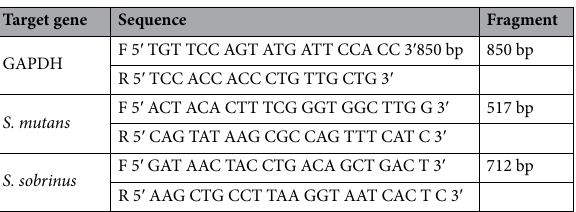
Table 1. Sequences of oligonucleotide primers used for the amplification of GAPDH and bacteria Streptococcus mutans and Streptococcus sobrinus . bp base pairs.